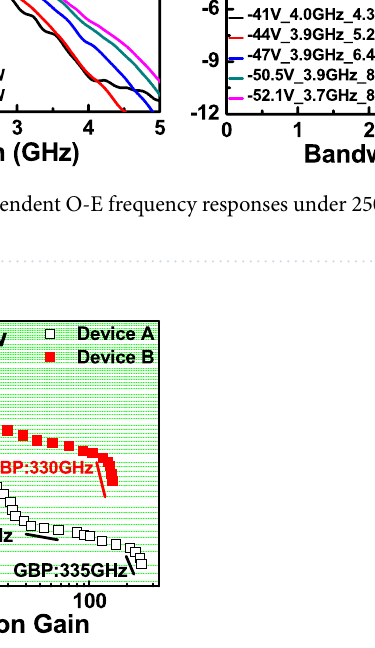
Figure 7. Measured 3-dB O-E bandwidths versus multiplication gain of the demonstrated APD at low (1 µW) optical pumping power for. ( a ) Device A. ( b ) Device